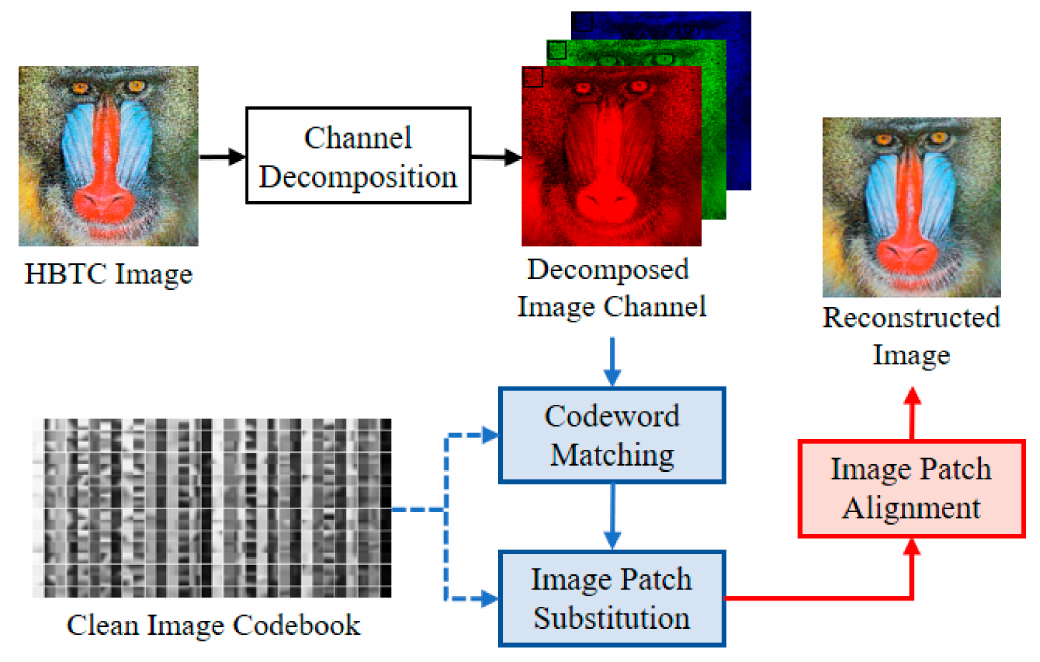
Figure 4. Schematic diagram of fast vector quantization (VQ)-based H-BTC image reconstruction